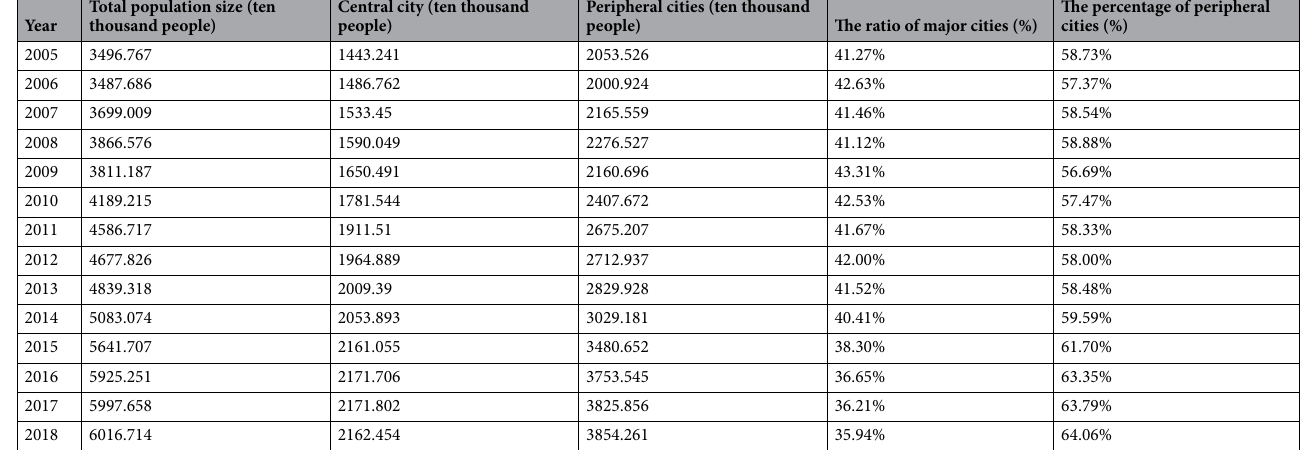
Table 1. The population size of each type of city in the BTHUA (more detailed data are available in supplementary